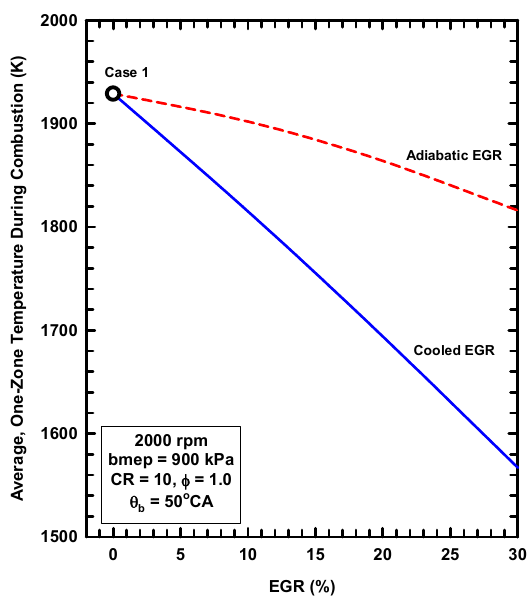
Figure 15. The average, one-zone gas temperature during combustion as functions of the EGR percentage for the two EGR configurations.